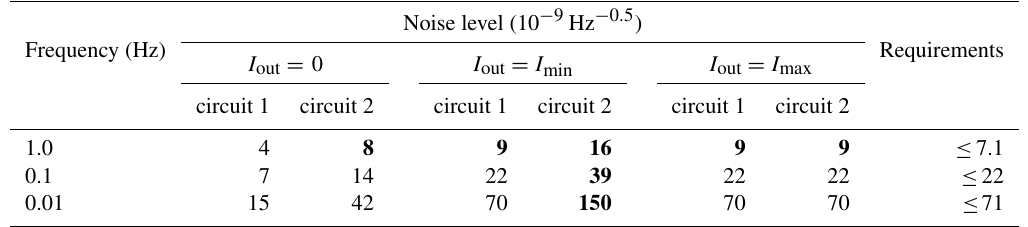
Fig. 7. The total temperature drift of the DAC output